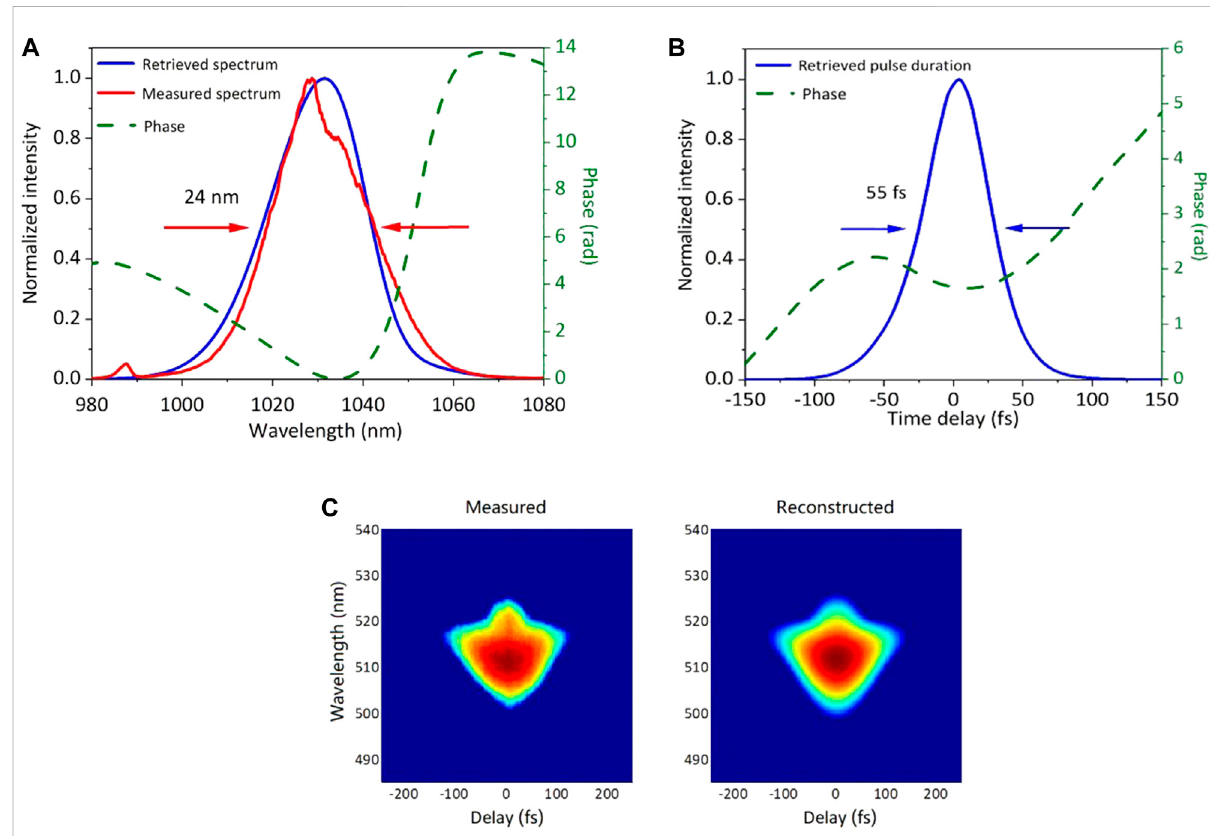
FIGURE 4 Characteristics of the output pulses. (A) Measured and retrieved spectra of the pulses. The measured spectrum extends from 980 to 1,080 nm. (B) Retrieved temporal intensity showing a pulse duration of 55 fs. (C) The comparison of the measured and retrieved FROG traces.